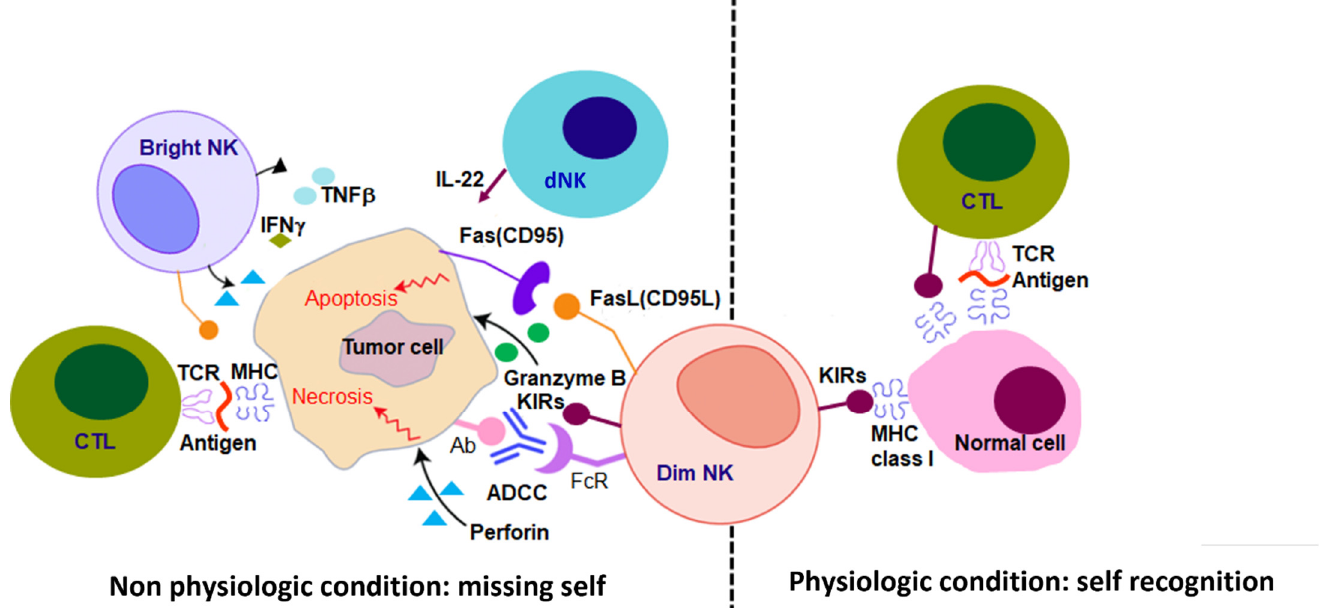
Figure 2. Two main mechanisms lead to NK-mediated cytotoxic activity of target cells: i) the release of cytoplasmic granules containing perforin and granzyme; and ii) the expression of tumor necrosis factor (TNF) family members, such as FASL or TNF-related apoptosis-inducing ligand (TRAIL), which induce tumor cell apoptosis. Moreover, most NK cells express the low-affinity activating receptor Fc γ RIIIa (CD16), which binds the Fc portion of immunoglobulin G1 (IgG1) and mediates antibody-dependent cellular cytotoxicity (ADCC). In physiologic conditions, a ‘self-recognition’ phenomenon is occurring, during which the binding of NK inhibitory receptor with self MHC class I allows the downregulation of the activating receptors and the tolerance of NK cells to self-tissue. In non-physiologic conditions, such as the insurgence of tumor malignancies or bacterial/viral infections, a ‘missing self’ phenomenon is instead observed, which is characterized by a downregulation or deletion of MHC class I molecules, a blockage of inhibitory signals, and the induction of NK cell activating and cytotoxic functions. Abbreviations: Bright NK, CD56 bright NK cells; CTL, cytotoxic T lymphocyte; Dim NK, CD56 dim NK cells; IFN- γ , interferon- γ ; IL-22, interleukin-22; KIRs, Killer Immunoglobulin-like Receptors; MHC, major histocompatibility complex; TCR, T cell receptor; TNF- β , tumor necrosis factor- β ; dNK, decidual NK